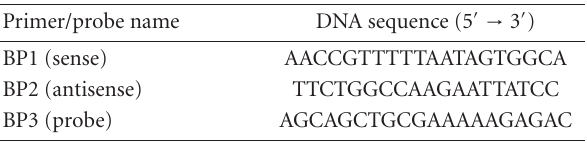
Table 1: The DNA sequence of PCR primers and the probe used for detection of C. trachomatis by PCR-EIA